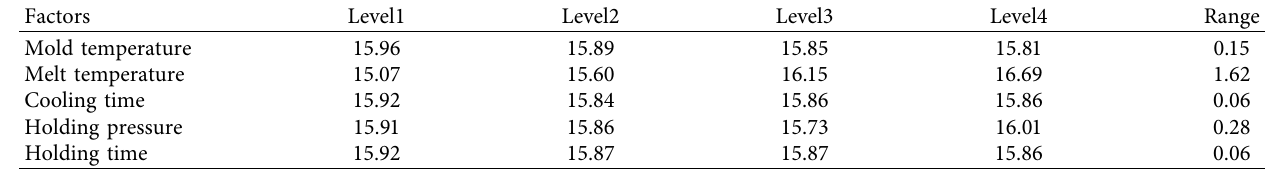
Table 5: Analysis of range of volume shrinkage.